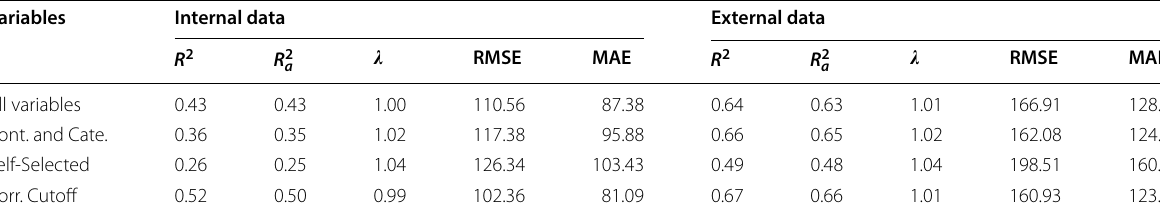
Table 2 PCA models’ R 2 , R 2 a , (cid:31) , RMSE, and MAE values. Variables